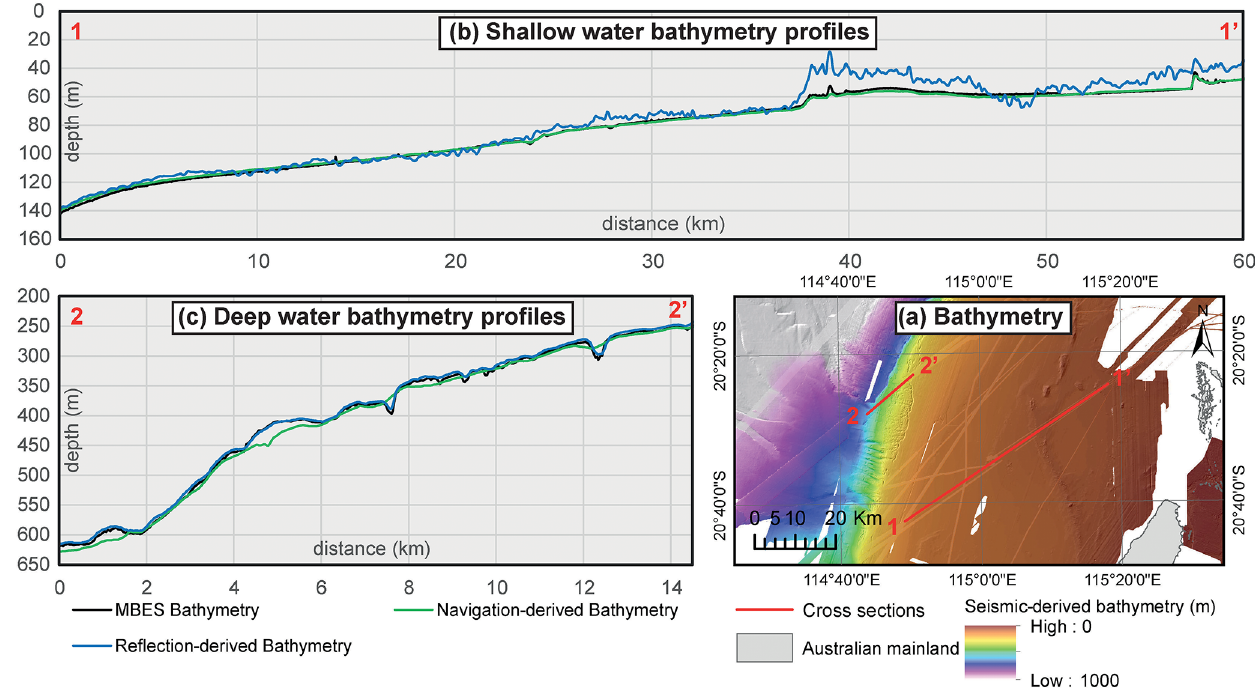
Figure 4. Comparison of the navigation-derived and reflection-derived bathymetry with MBES surveys in the vicinity of Barrow Island (a) . Reflection data are heavily distorted in shallow waters (cross section b , from km 37), whereas navigation data are over-smoothed in deep waters (cross section c , km 0–9). For data sources, see Sects. 3.3, 4.2.1, and